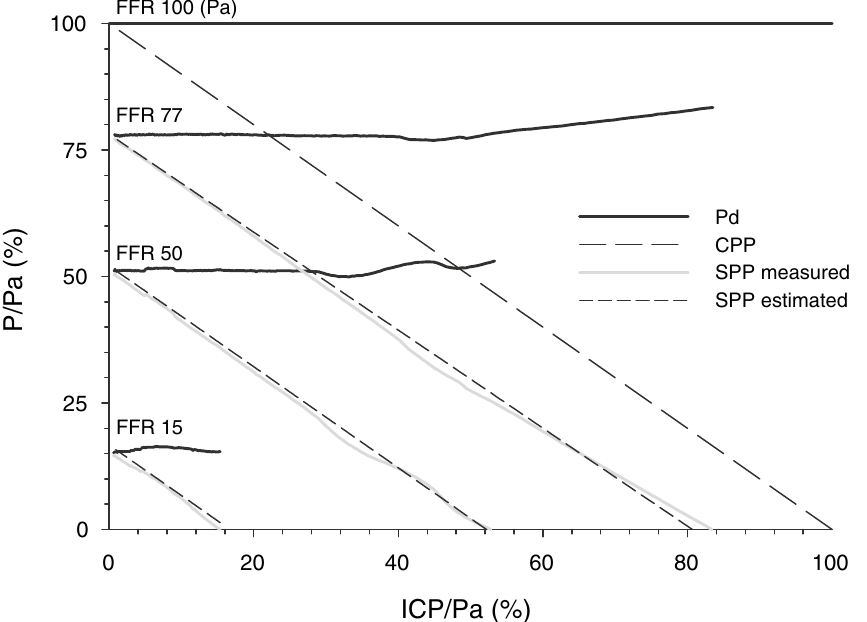
Figure 2. Bench verification of the segmental perfusion pressure (SPP) equation: intra-extracranial flow simulated by the irrigation set with inflow pressure Pa flowing through the adjustable clamp and dividing into two outflow pathways: collapsible Penrose drain through the chamber with pressure ICP and bypass representing intracranial compartment and extracranial vascular bed. Pd is pressure distal to the clamp. Here Pd, SPP, and ICP are scaled to Pa. Correspondingly, SPP = Pd–ICP and fractional flow reserve (FFR) is Pd/Pa. Experimental data for FFR 77, 50, and 15 are shown. As chamber pressure is increased, Pd rises due to partial obstruction of the collapsible outflow pathway in the Starling chamber. Estimated SPP represents the best fit of the SPP equation. When FFR is 100, SPP is equivalent to the cerebral perfusion pressure CPP. SPP estimation error 0.81 ± 0.57, n = 1226 (scaled to the inflow pressure Pa) is comparable to the manufacturer specified pressure transducer measurement error in the bench system (2% of the